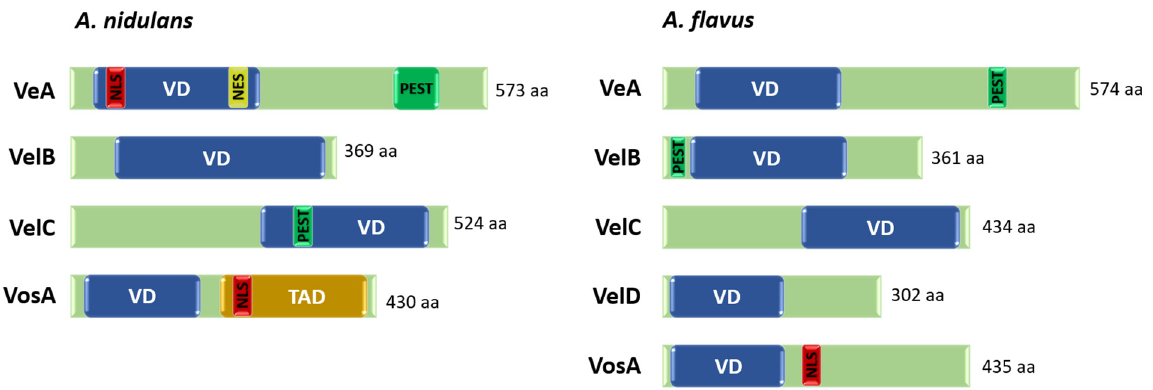
Figure 4. Domain architecture of the velvet regulators in A. nidulans and A. flavus . VD: velvet